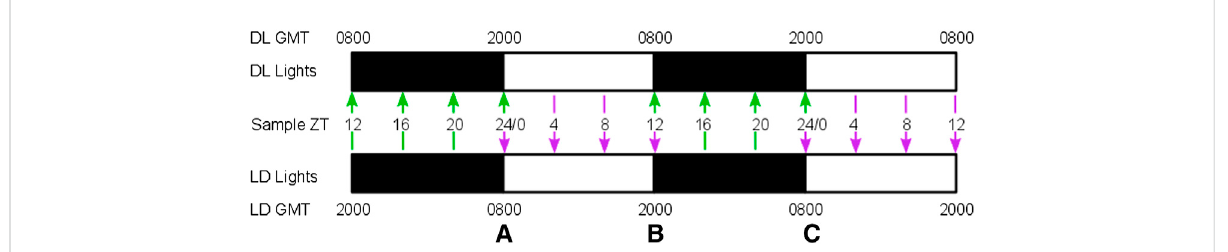
FIGURE 1 Sampling regime. Mice were allocated to one of two 12 h dark: 12 h light lighting regimes, with lights on at 0800 GMT for the standard lighting regime (LD) and 2000 GMT for the reversed lighting regime (DL). Black and white bars indicate time of dark and light respectively. The offset lighting regimes were used to obtain 4-hourly sampling across a 48 h timeframe by concatenating samples from the DL group (green arrows) and LD group (purple arrows), as indicated by the sampling day and ZT time (Zeitgeber time, i.e., hours since lights on). This design generated three points of overlap (A – C) when both LD and DL mice were sampled at comparable points to verify each cohort within each treatment group is a good replicate of the other. RBC densities were collected for both cohorts at the second and last overlaps, and parasitemia was measured for all three